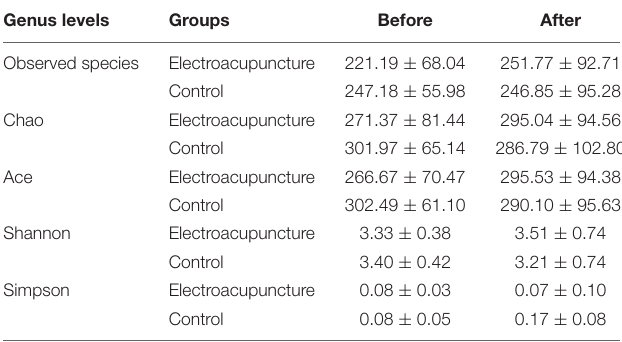
TABLE 6 | Comparison of Alpha diversity between two groups of patients before and after treatment (x ± s). Genus levels Groups